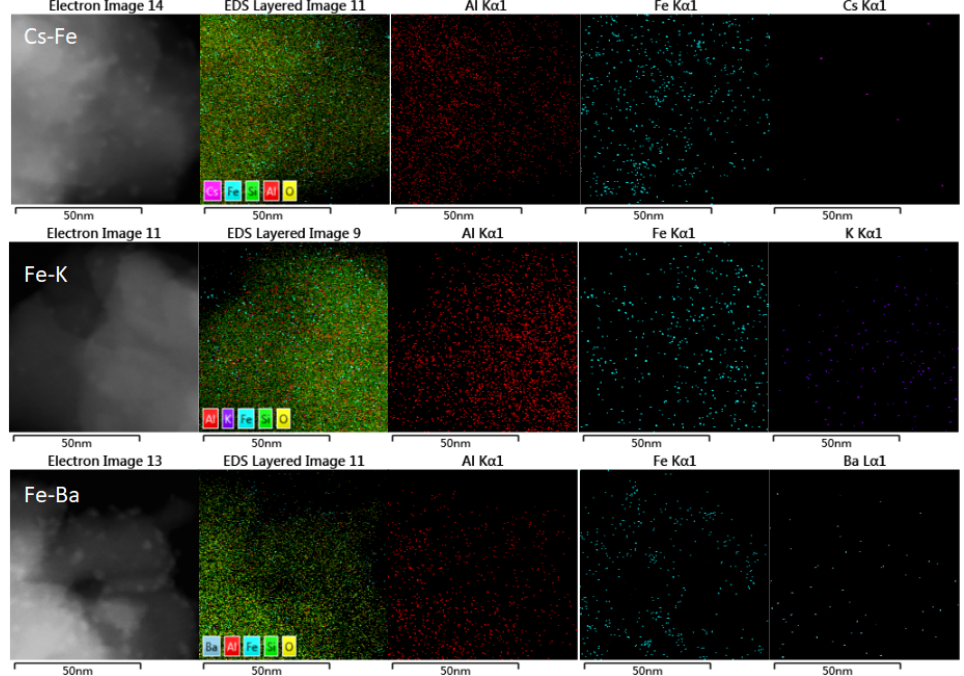
Figure 9. HAADF-STEM images of Cs-, K- and Ba-doped Fe-HZSM-5 with corresponding elemental mapping analysis.